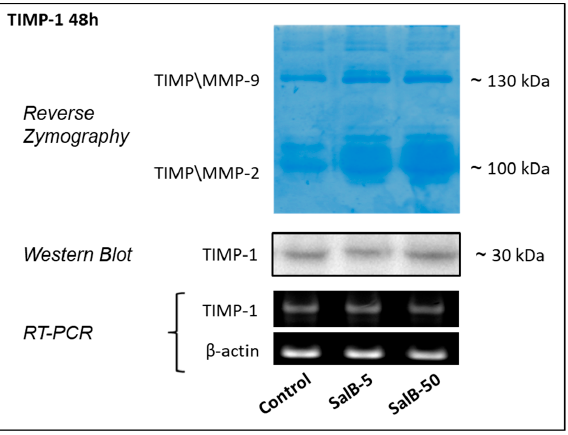
Figure 5. Analysis of TIMP-1 through reverse zymography, Western blot and RT-PCR. The role of the tissue inhibitor of metalloproteinases-1 (TIMP-1) has been evaluated through reverse zymography and Western blot that were performed on conditioned media obtained from MDA-MB-231 cells treated for 48 h with SalB 5 and 50 µ M. In the same sampling were also collected cells for transcripts evaluation by